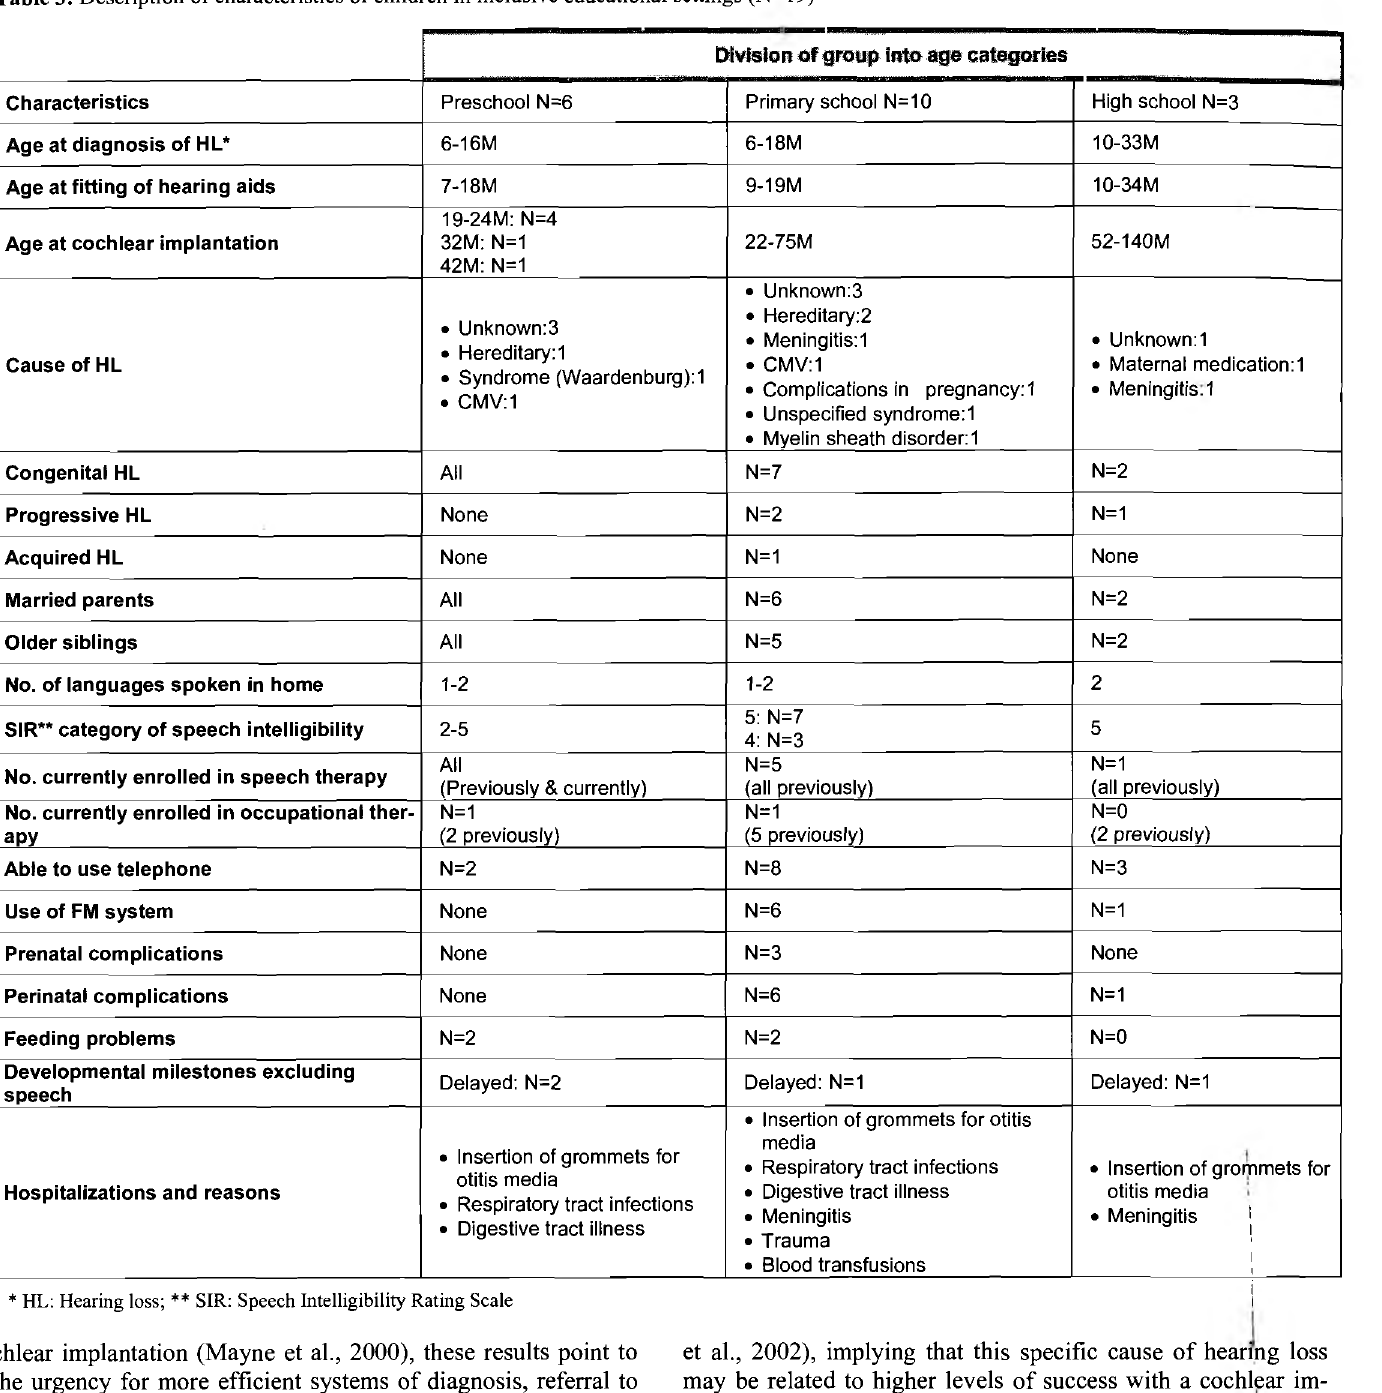
Table 3: Description of characteristics of children in inclusive educational settings